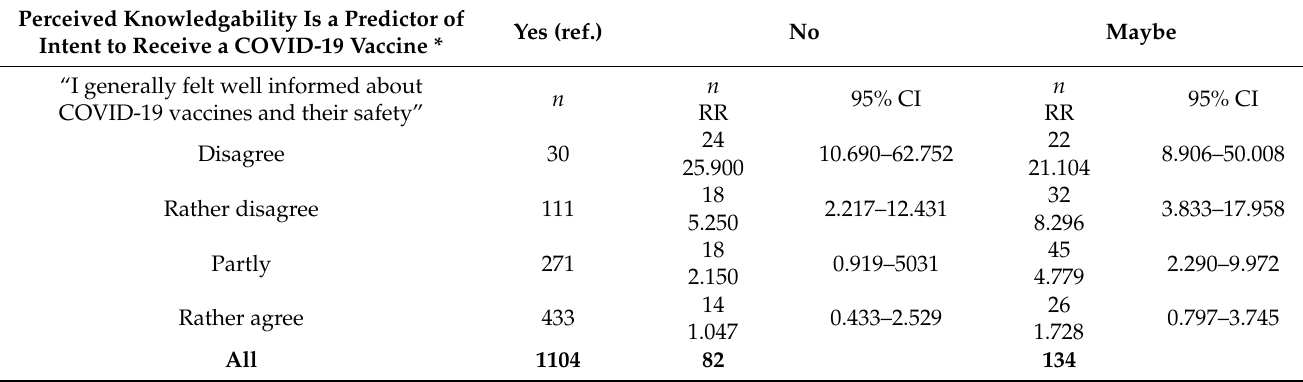
Table 8. Multinomial logistic regression for the perceived knowledgeability associated with intent to receive a COVID-19